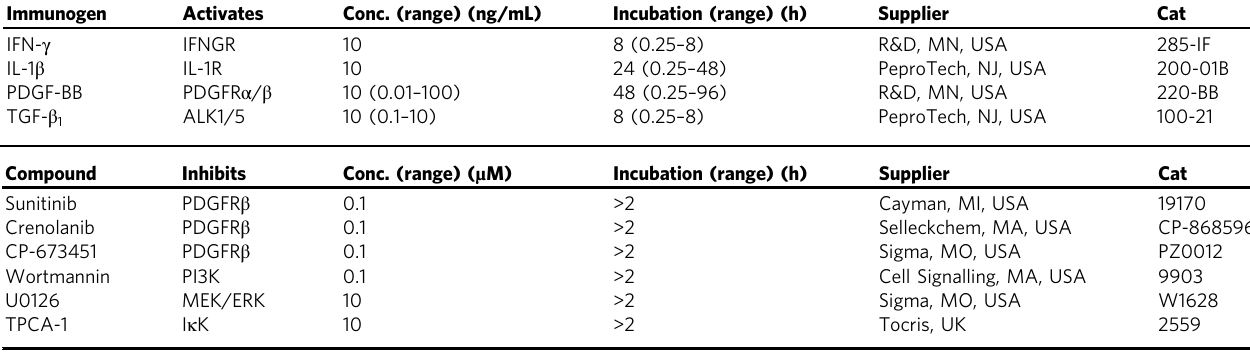
Table 1 Speci fi cations for cytokines and inhibitors